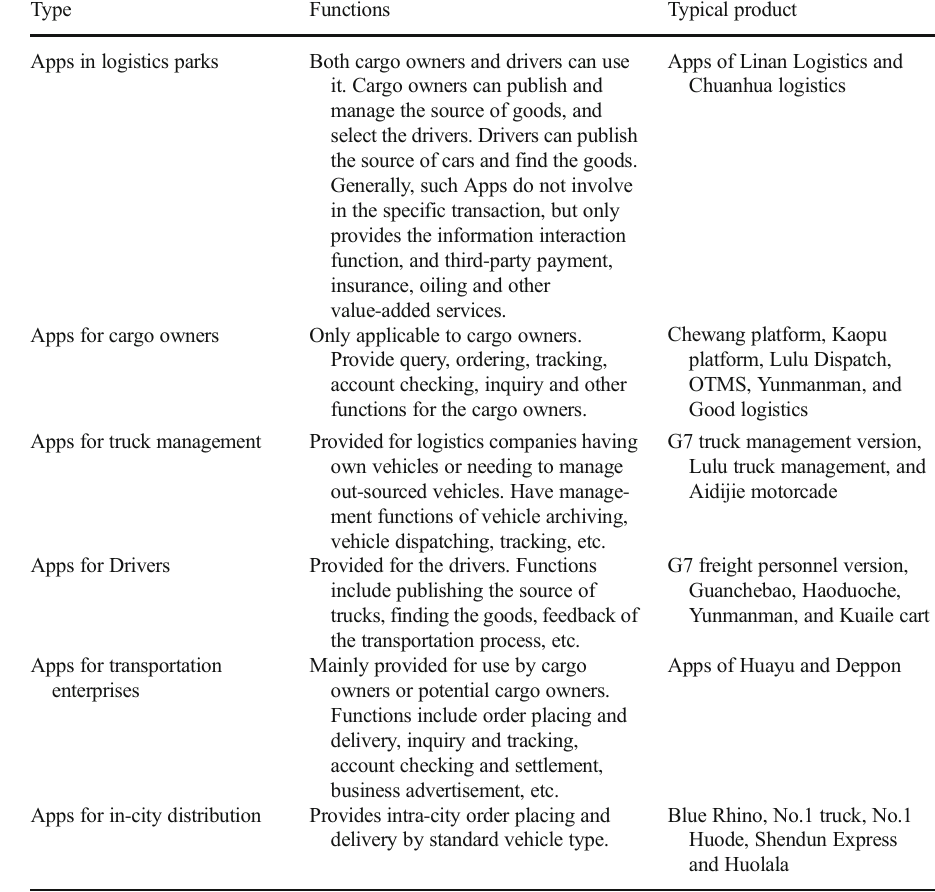
Table 1 Major types of freight app use in